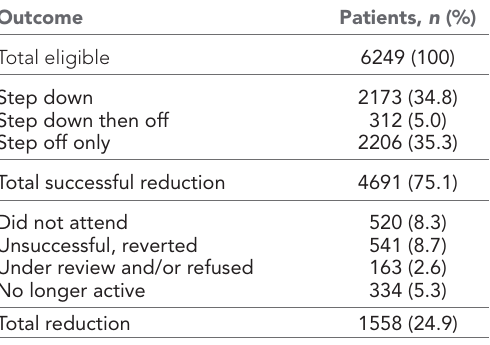
Table 1 Net impact of DTREP programme on